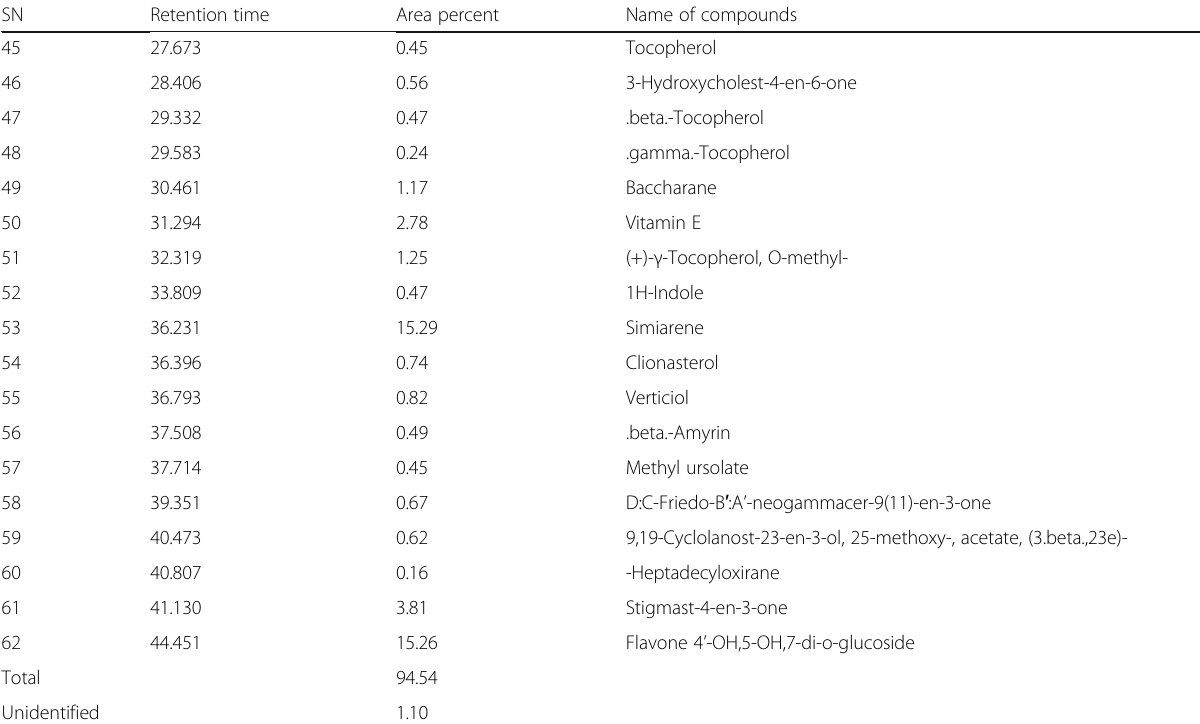
Table 2 GC-MS analysis of Quercus leucotrichophora (Leaves) extract (Continued) SN